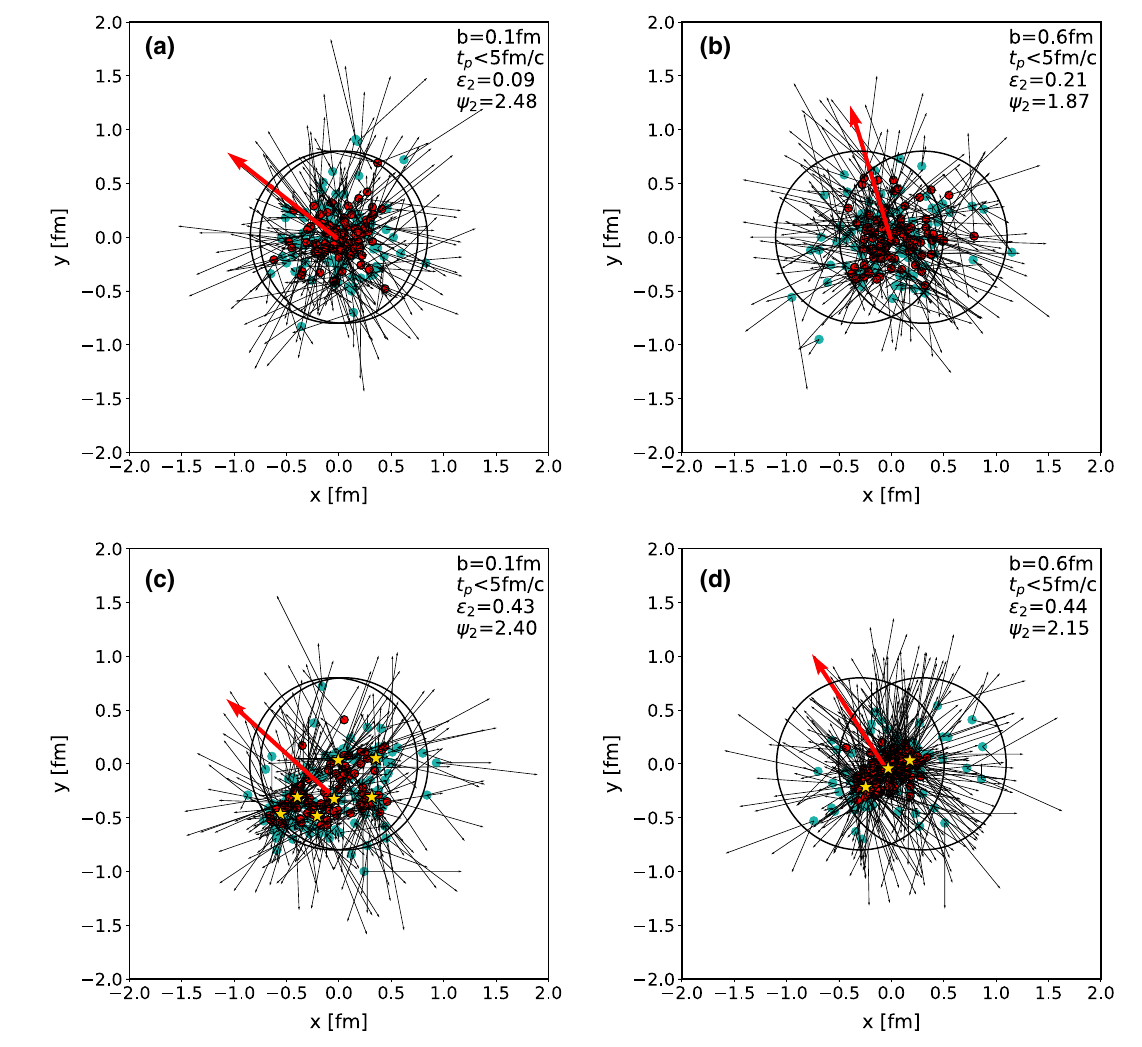
Fig. 3 Transverse view of the created parton system in a high mul- tiplicity event ( N parton > 600) with the overlap function weighting method (upper panel) and the constituent quark method (lower panel) in a central collision at b = 0 . 1 fm (left column) and in a peripheral collision at b = 0 . 6 fm (right column). Coordinates of the partons are